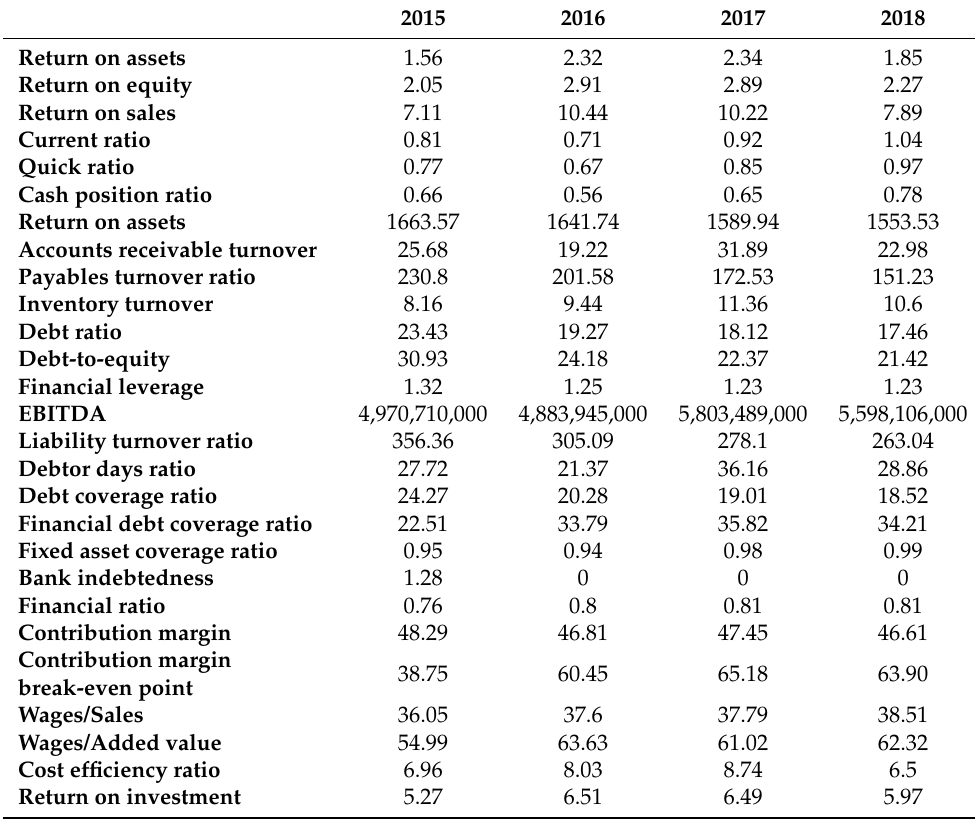
Table 33. Results of ratio for the company Dopravn í podnik hl. mˇesta